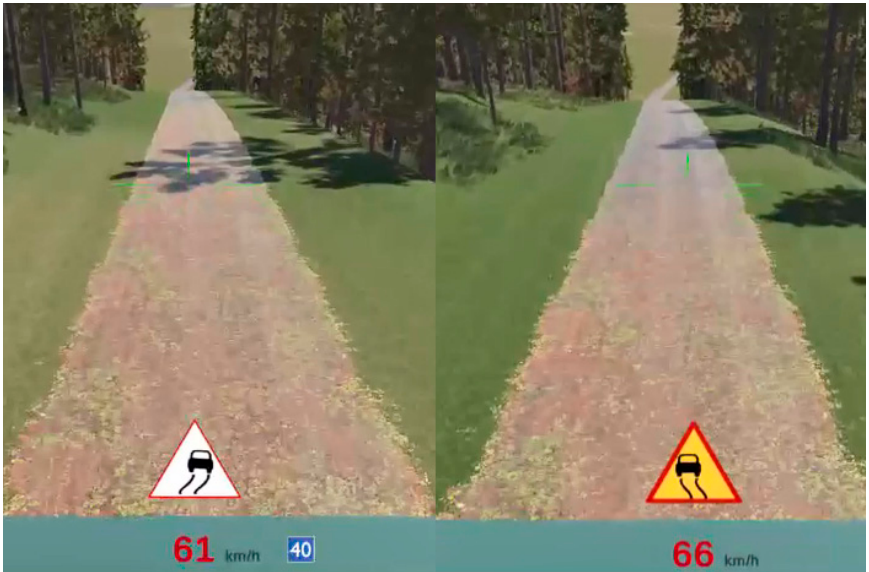
Figure 3. Two levels of animated visual warning.